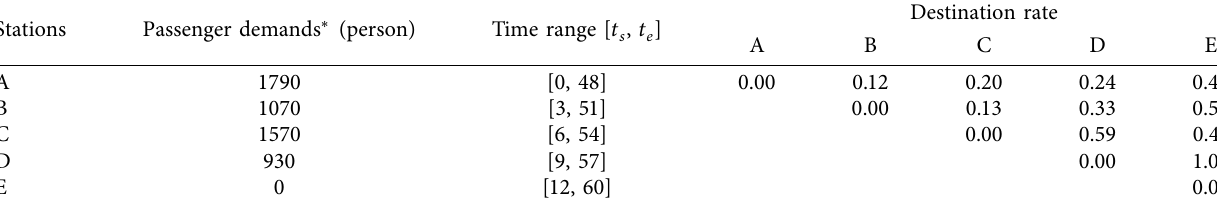
Table 3: Characteristics of passenger flow for each station.